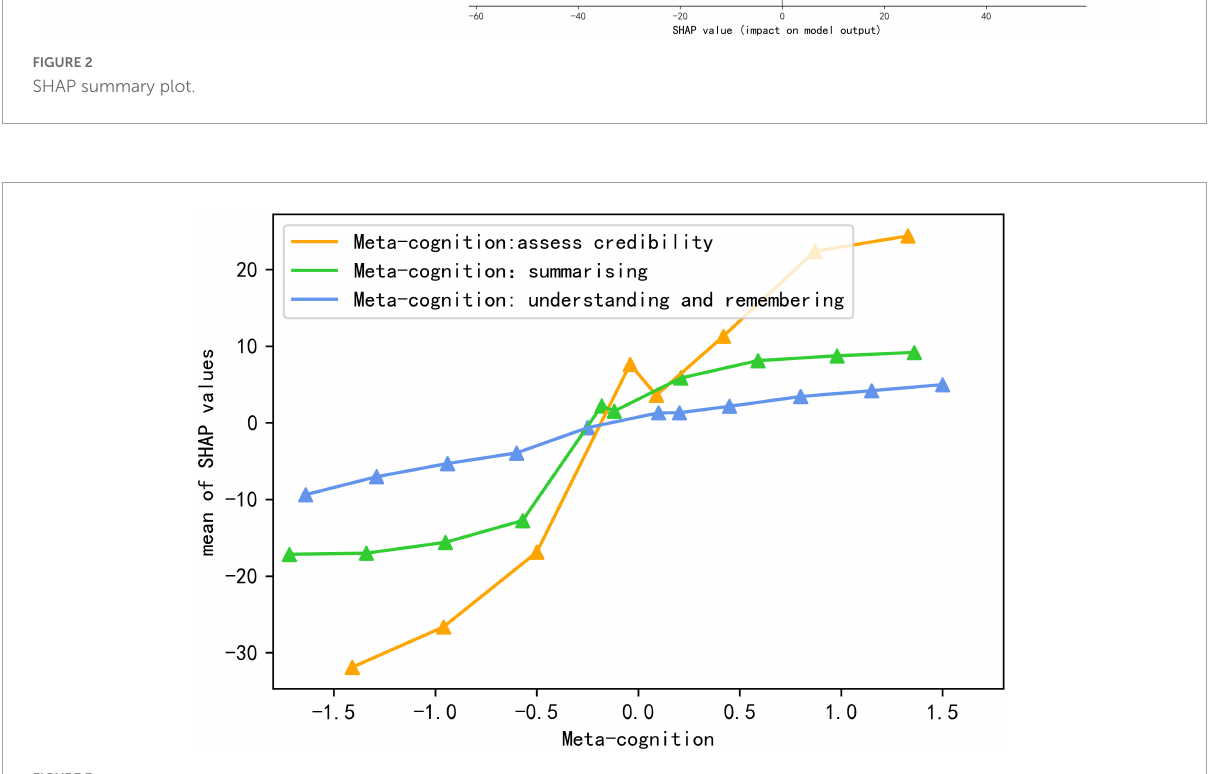
FIGURE2 SHAP summary plot.